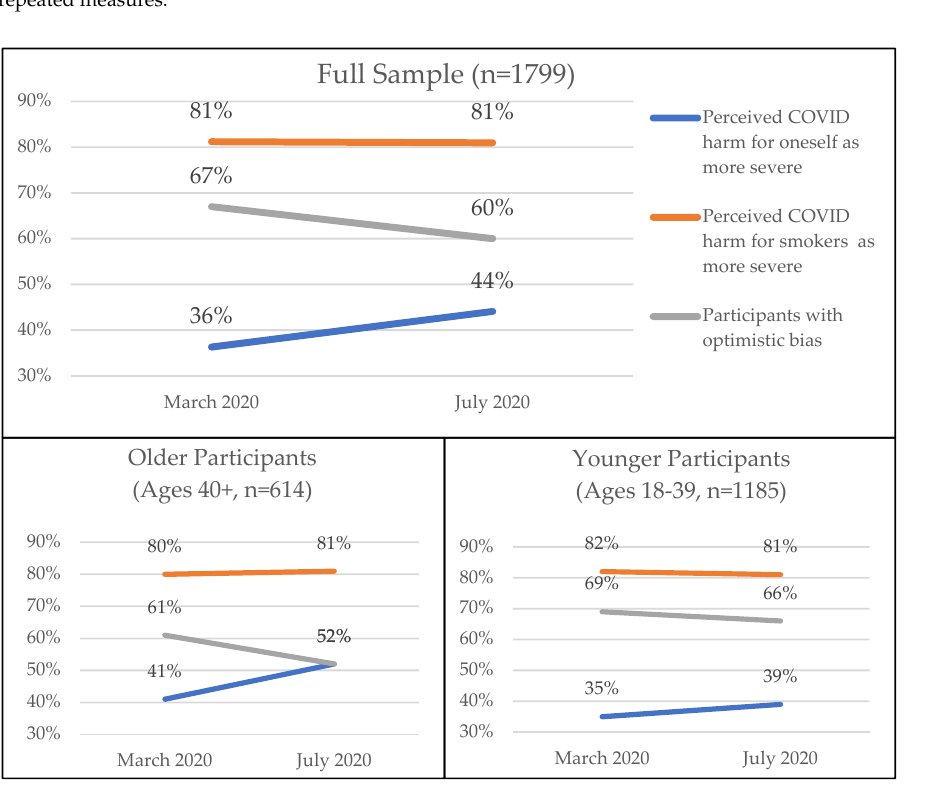
Figure 1. COVID-19 severity perceptions and optimistic bias by wave and between age groups among Mexican adult smokers and dual users (Sample B, 2020).